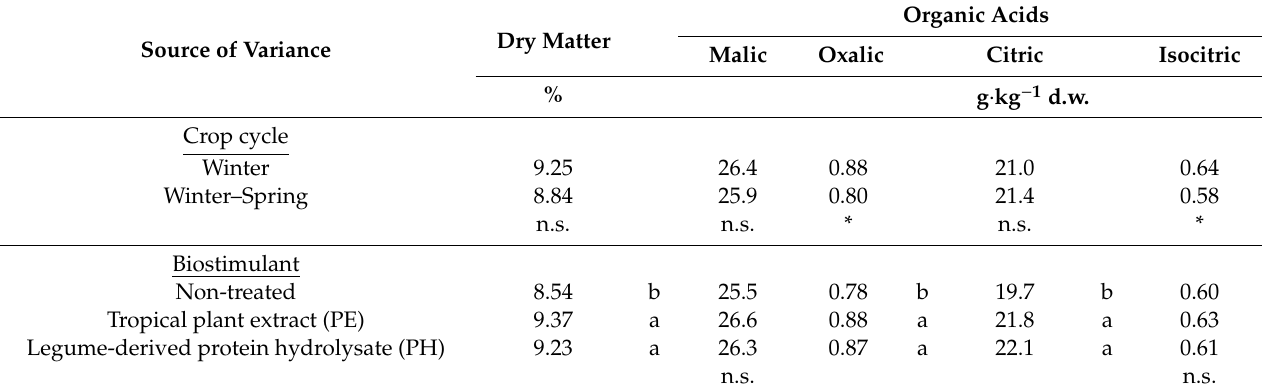
Table 3. Mean values of perennial wall rocket leaf quality indicators as a ff ected by crop cycle and